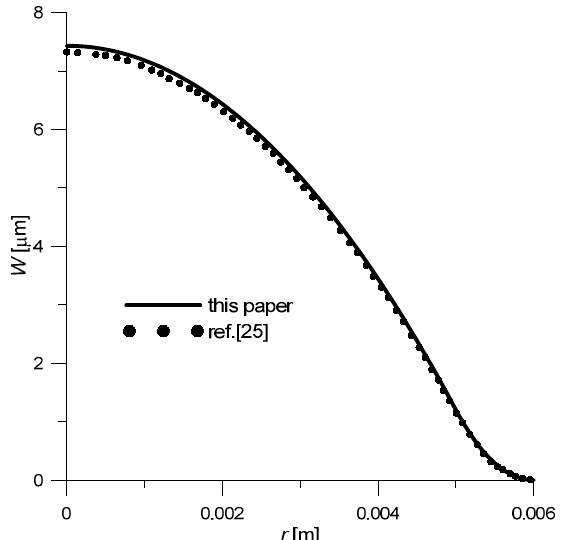
Figure 4. Comparison of deflection curves: solid line—analytical solution (23); dashed line—analytical solution taken from the work [25] (p. 36), V = 200 V, R = 6 × 10 − 3 m, R o = 5 × 10 − 3 m, t 1 = 2 × 10 − 4 m, t 2 = 1.5 × 10 − 4 m, Pz26/Cu.